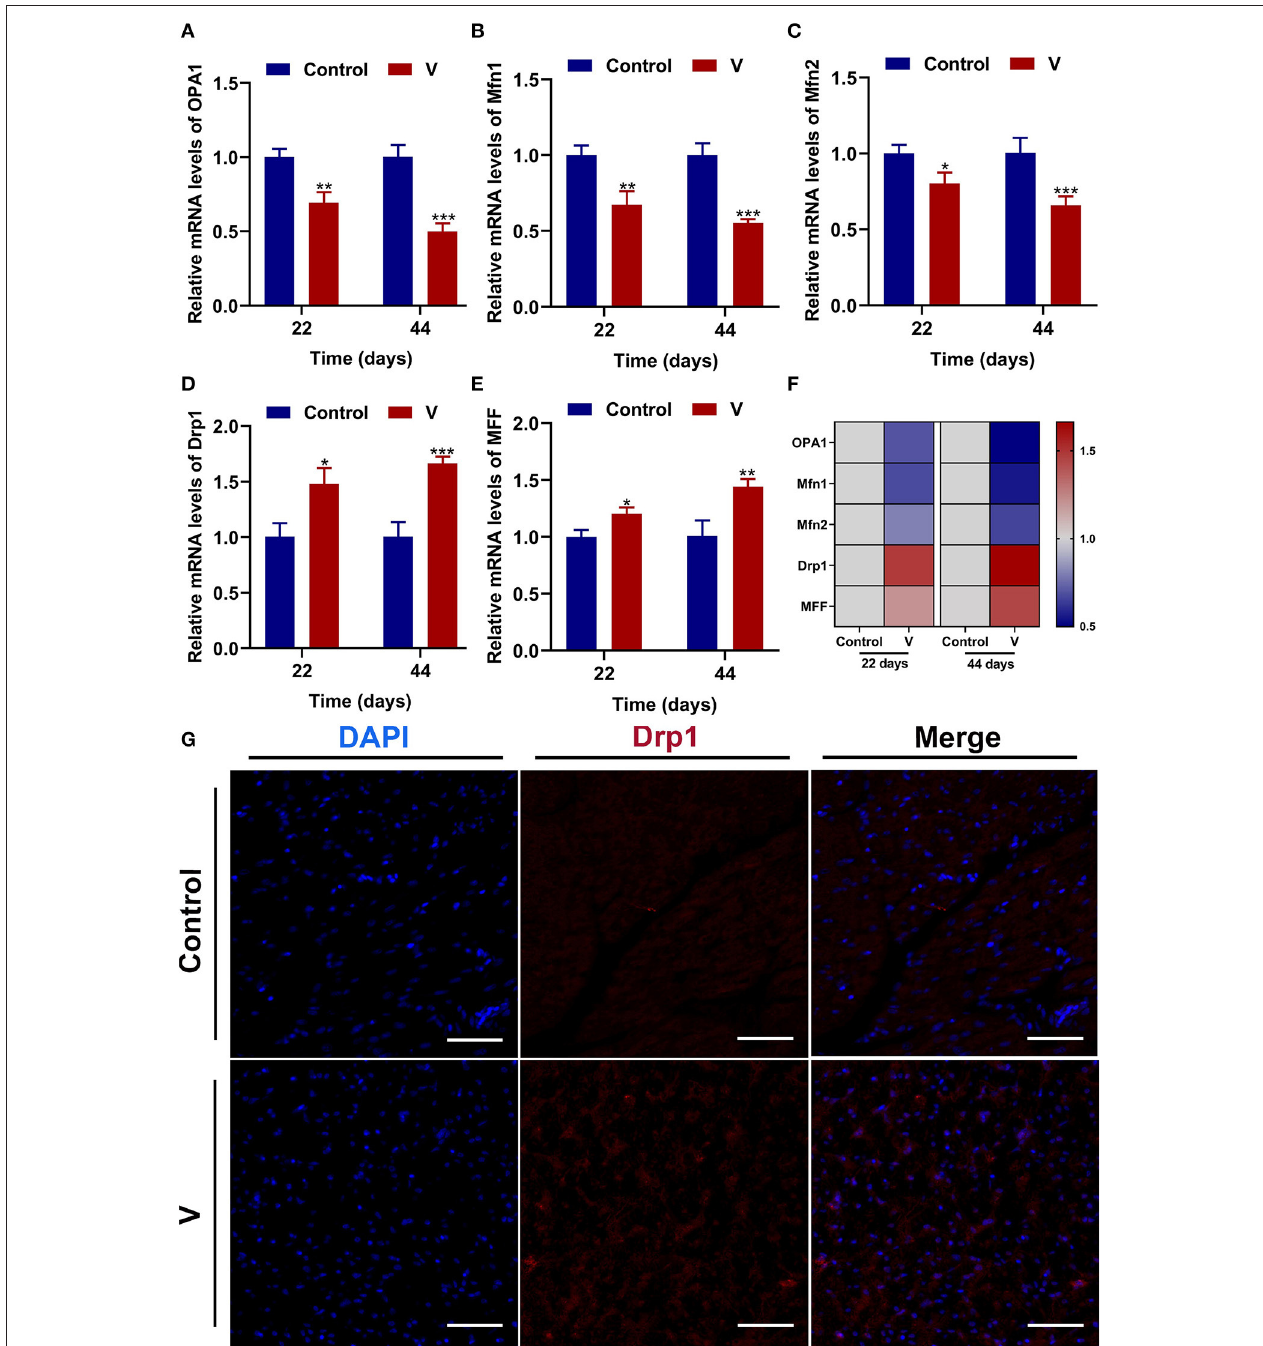
FIGURE 4 | The effects of V on mitochondrial fission and fusion in the heart of ducks. (A–E) OPA1, Mfn1, Mfn2, Drp1, and MFF mRNA expression levels. (F) Heatmap analysis of mitochondrial fission and fusion-related mRNA levels. (G) Fluorescence microscope analysis of mitochondrial fission. In this picture, the nucleus straining is shown in blue, Drp1 straining is shown in red, and the bright red light is the fluorescent spot ( × 400 total magnification). Scale bar: 20 µ m. * p < 0.05, ** p < 0.01, and *** p < 0.001.